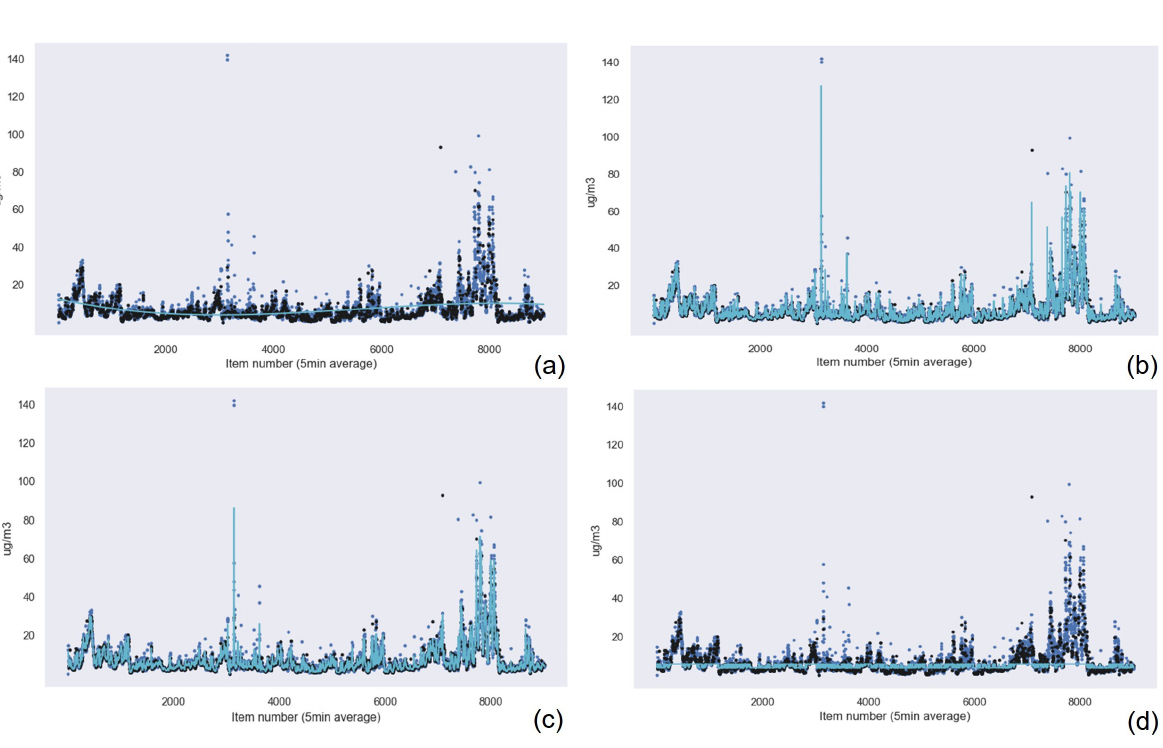
Figure A15. Cont